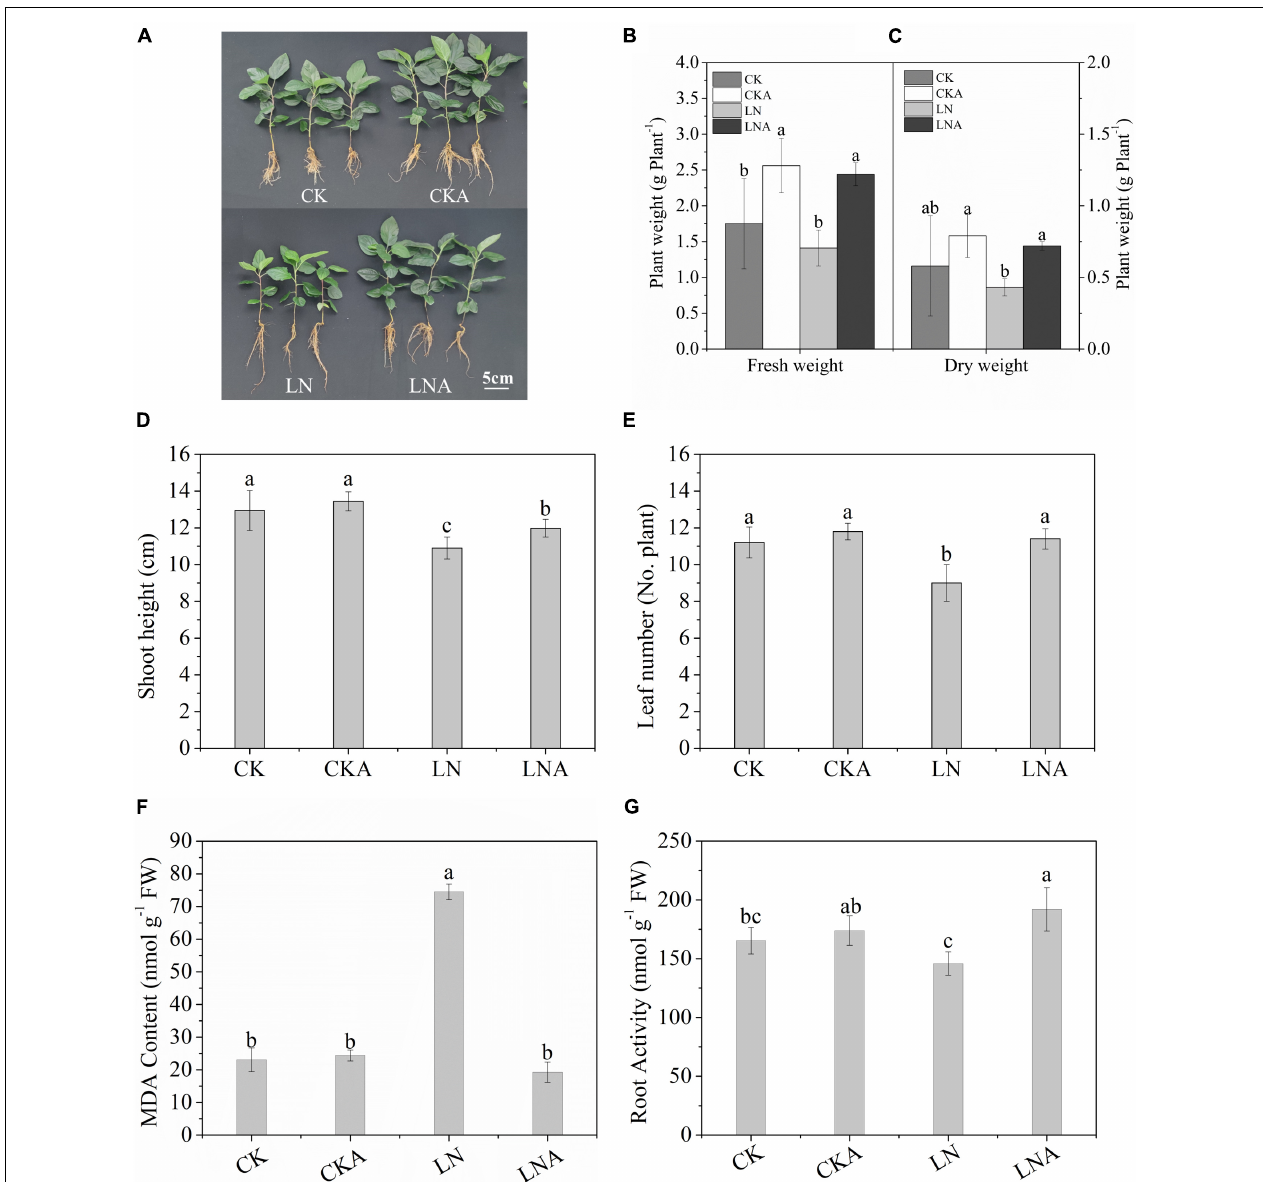
FIGURE 2 | Analysis of the growth parameters of CK, CKA, LN, and LNA at 20 days. We measured the phenotype (A) , fresh weight (g − 1 plant) (B) , dry weight (g − 1 plant) (C) , shoot height (cm) (No. plant) (D) , and the number of leaves (E) of apple plants from these four treatments. The content of MDA after 20 days (F) . Root activity of CK, CKA, LN, and LNA after 20 days of treatment (G) . Half-strength nutrient solution (CK); half-strength nutrient solution + 100 µ mol L − 1 arginine (CKA); N-deficiency solution (LN); and N-deficiency solution + 100 µ mol L − 1 arginine (LNA). Values are means of five replicates ± SD. Values not represented by the same letter are significantly different according to Tukey’s multiple-range test ( P <